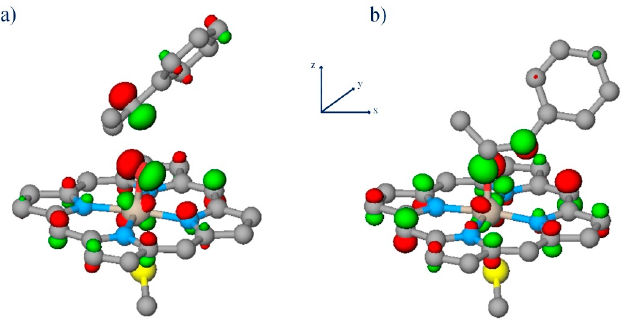
Figure 5. Oxyferryl π * attack on C=C bond for model CPO-I-A: ( a ) LUMO in β manifold of 1R2S TS ; ( b ) LUMO in β manifold of 1S2R TS .